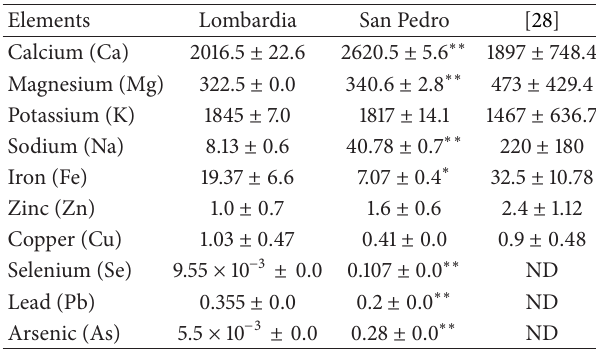
Table 2: Measured concentration in (mg/100g) of trace element in the M. oleifera leaf